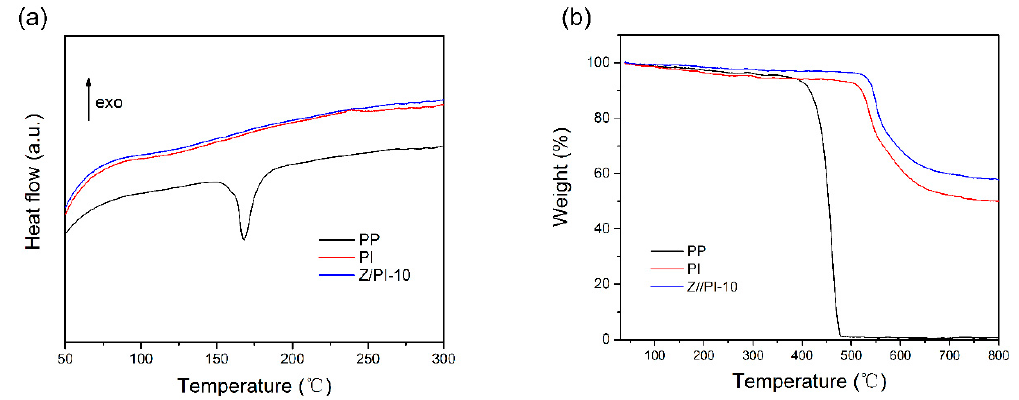
6 of 12 Table 1. The composition, thickness, and porosity of different separators. Sample 61 Figure 3. The stress–strain curves of different separators. The thermal stability of the separators is an important indicator to assess the safety of the battery. DSC was carried out to evaluate the thermal behaviors of the prepared separators. From the DSC profile of the PP separator, shown in Figure 4a, an obvious endothermic peak at about 167 °C is detected, which is the melting temperature of PP [25,26]. In contrast, no obvious peaks are observed in the range of 50–300 °C for both the pristine PI separator and Z/PI-10 composite separator, and there is a negligible difference among the PI separator and Z/PI-10 composite separator, indicating that the PI-based separators possess significant thermal stability up to 300 °C. Meanwhile, to further evaluate the thermal behaviors of the separators, a TGA test was performed, and the results are shown in Figure 4b. It can be found that the PP separator develops a sharp degradation at around 400 °C, and it thoroughly decomposes at above 475 °C. However, the weight